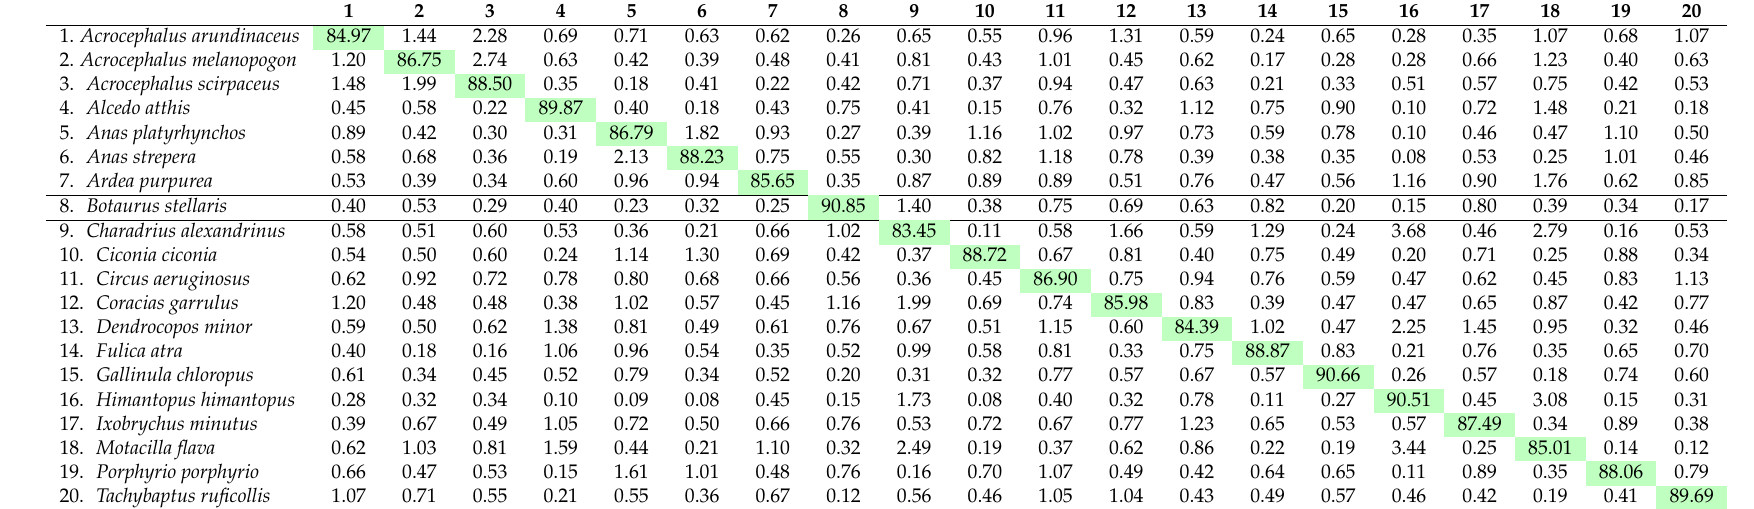
Table 6. Confusion matrix of the GMM-based birdsong classifier. Predicted classes are on the columns and actual classes are on the